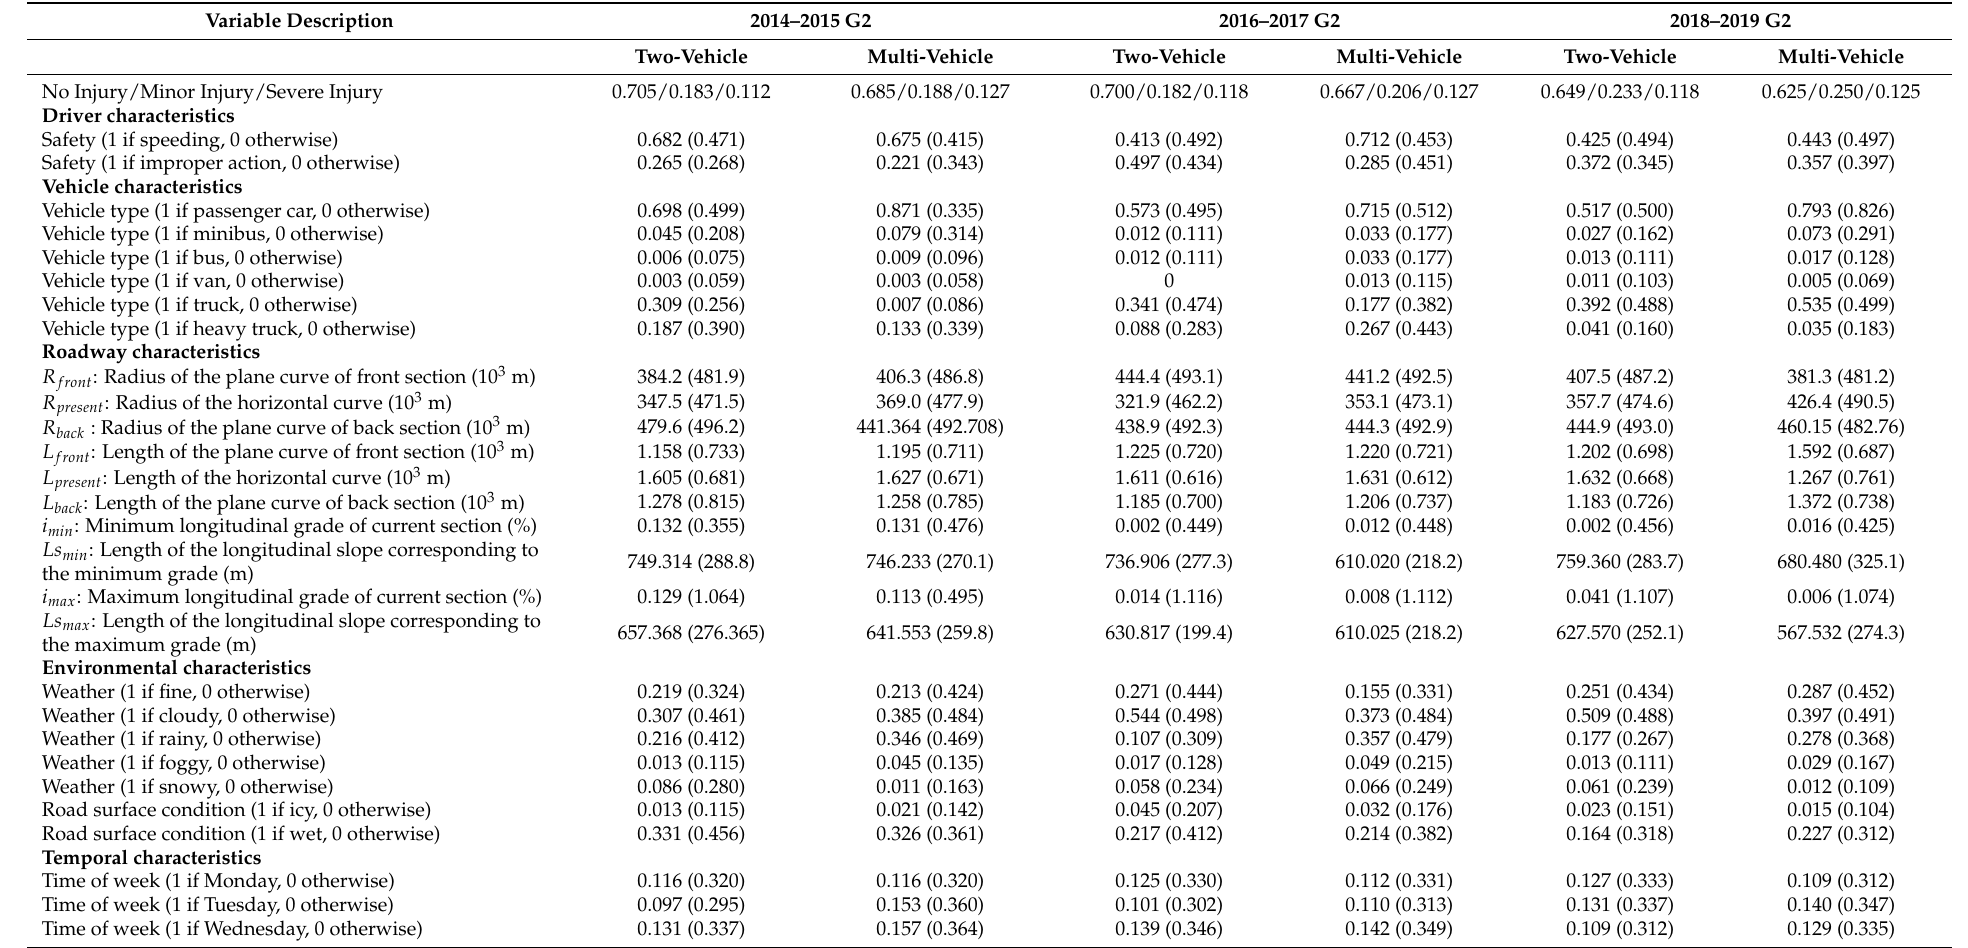
Table 1. Descriptive statistics of variables in two-vehicle and multi-vehicle freeway rear-end crashes in Beijing-Shanghai Freeway (G2) (Std. Dev. in